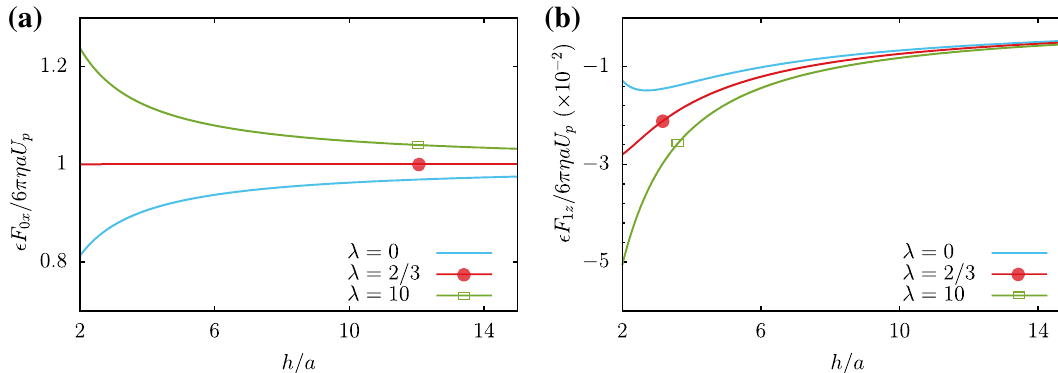
Figure 2. ( a ) The zeroth order hydrodynamic force acting on the particle in terms of the distance to wall is plotted. This force is parallel to the wall. ( b ) The first order force is perpendicular to the wall and it is plotted in terms of the distance to wall. Parameters are U p